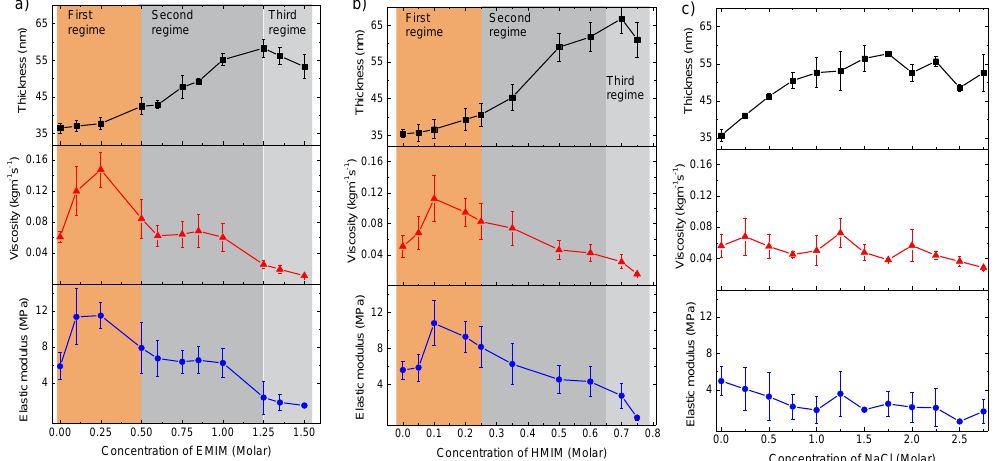
Figure 5. Modeled thickness, viscosity and elastic modulus of PEI(PSS/PDADMAC) 4 PSS upon swelling with the aqueous solution of ( a ) EMIM ( b ) HMIM and ( c ) NaCl at the given concentrations. Changes in the modeled parameters in different concentration regimes of ILs are highlighted. The error bar is the standard error from averaging over 3 data sets at the respective salt concentration.